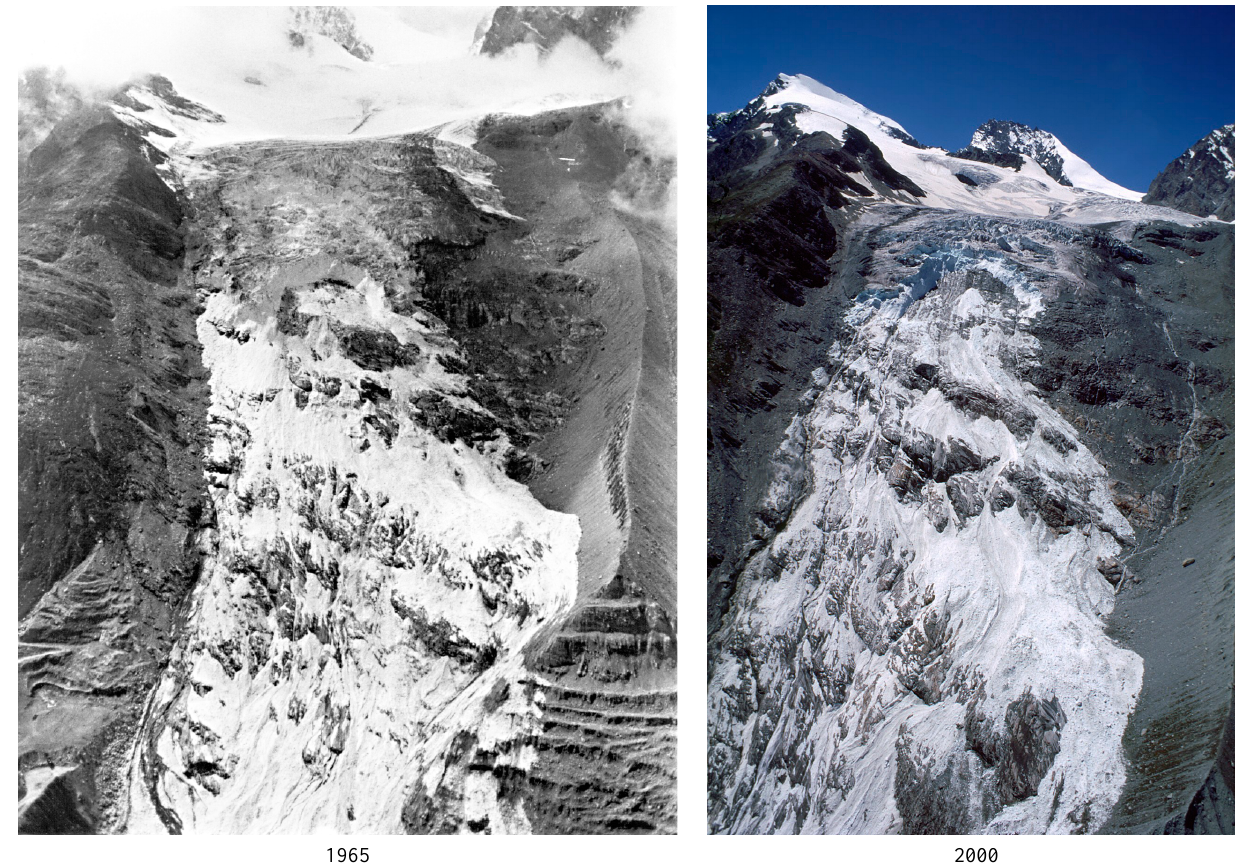
Fig. 7. Allalingletscher after the 1965 event (2millionm 3 of ice on 30 August 1965) and after the 2000 event (1millionm 3 on 31 July 2000). (Photo H. R¨othlisberger (left) and F. Funk-Salam´ı